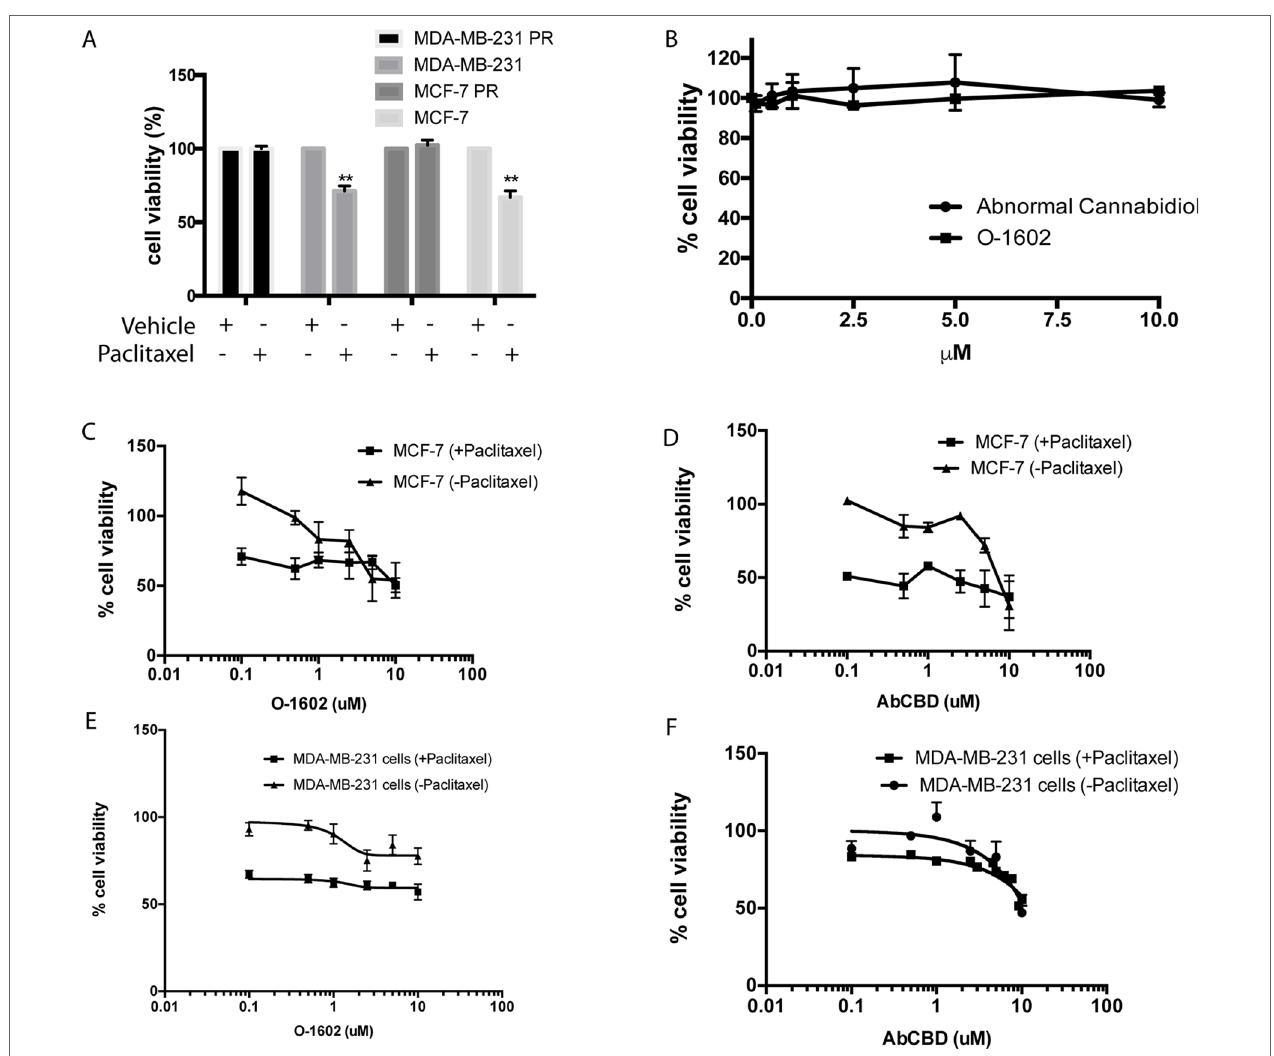
FIGURE 2 | Cell viability. (A) Effect of paclitaxel on sensitive and resistant (PR) MCF-7 and MDA-MB-231 cells. (B) Effect of O-1602 and Abn-CBD on the cell viability of MCF-10A cells. (C) Cell viability measured in paclitaxel-sensitive MCF-7 cells following 48-h treatment with various concentrations of O-1602 alone or in presence of paclitaxel. (D) Effect of Abn-CBD ± paclitaxel on taxol-sensitive MCF-7 cells. (E) Effect of O-1602 ± paclitaxel on taxol-sensitive MDA-MB-231 cells. (F) Effect of Abn-CBD ± paclitaxel on taxol-sensitive MDA-MB-231